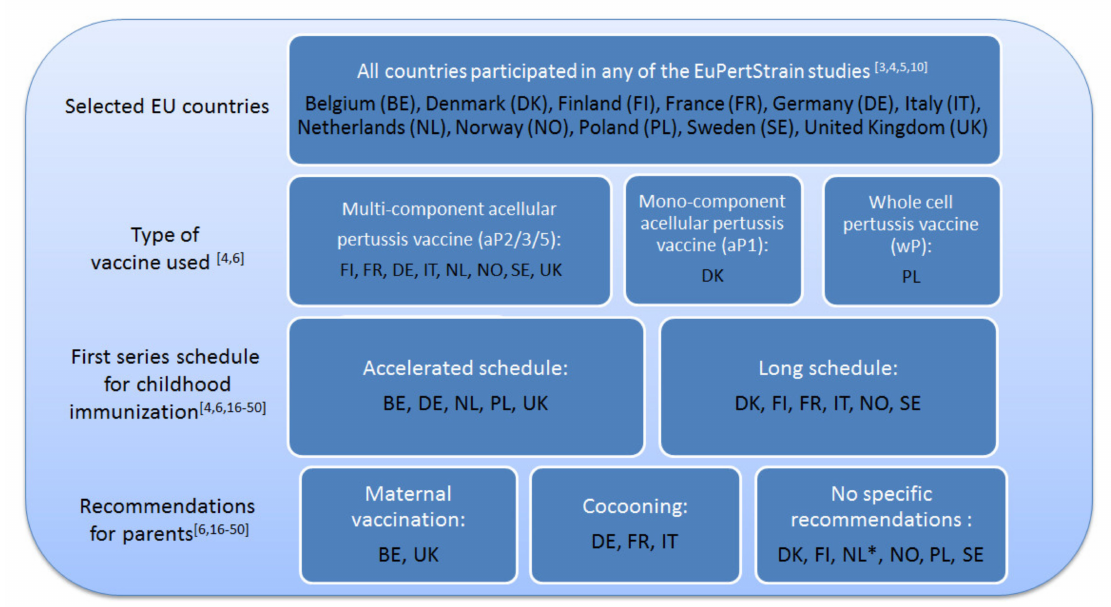
Figure 1. The type of vaccine used, the first series immunization schedule and recommendations for parents in 11 EU countries (* NL started recommendations for maternal vaccination during the